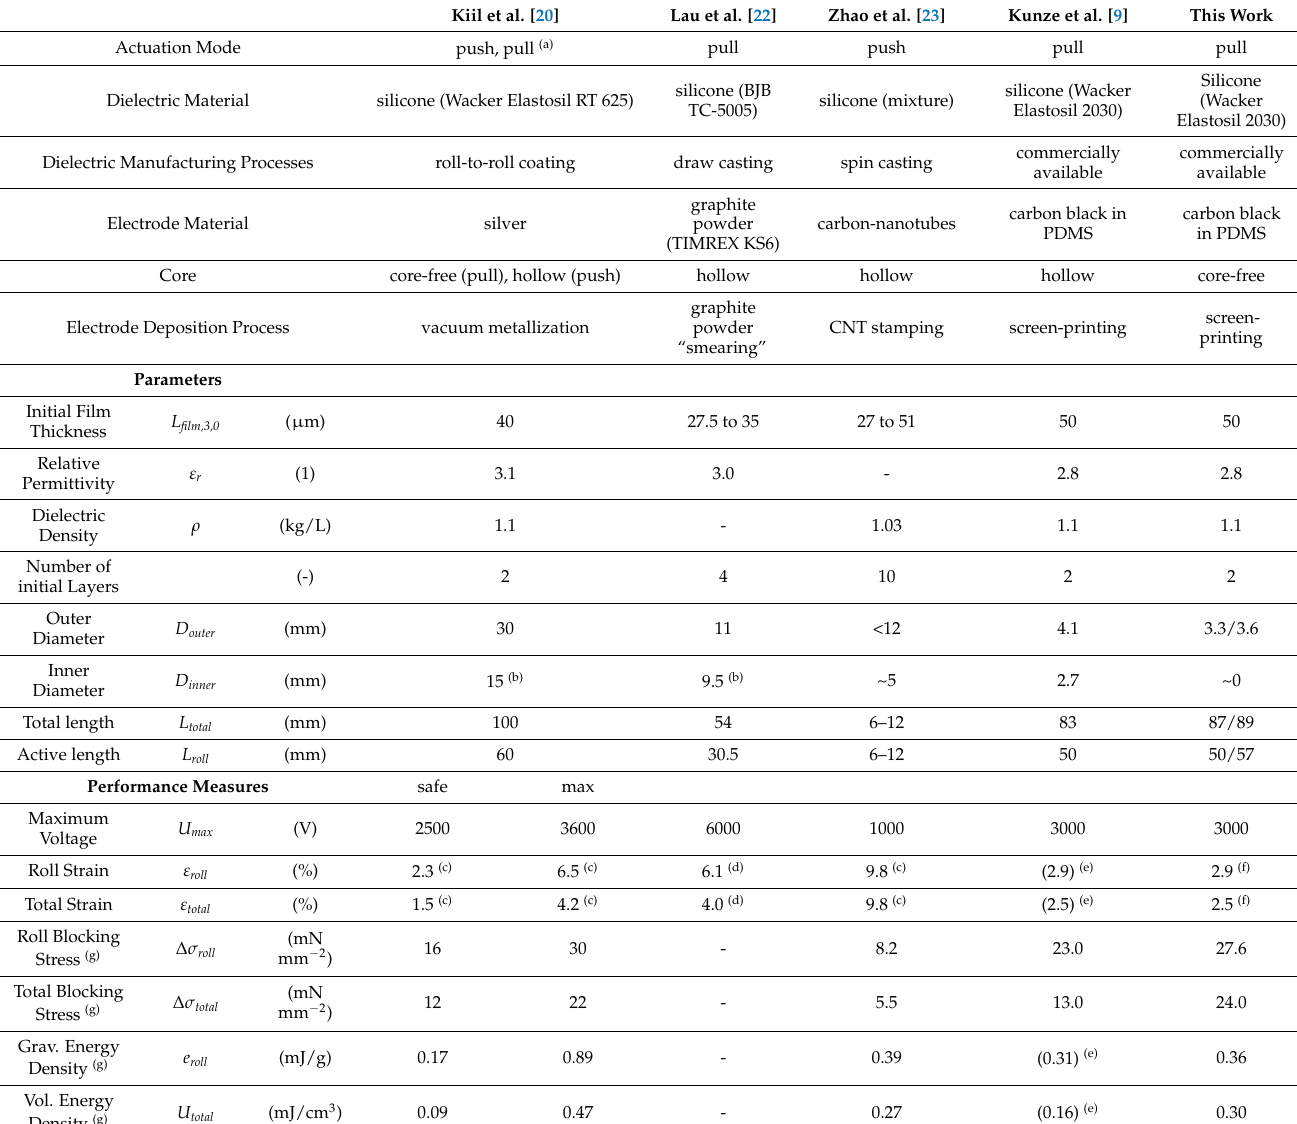
Table 4. Comparison of RDEAs based on